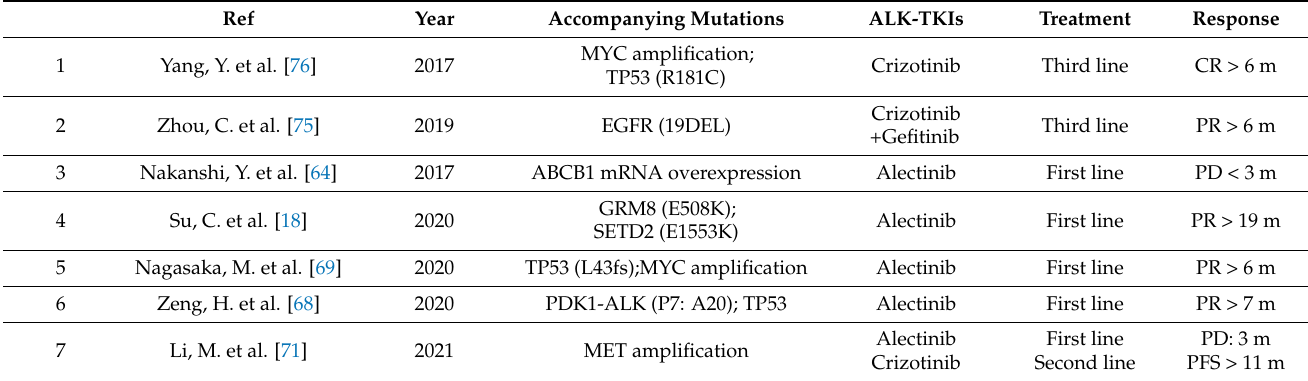
Table 1. Published details of STRN-ALK-positive NSCLC patients treated with